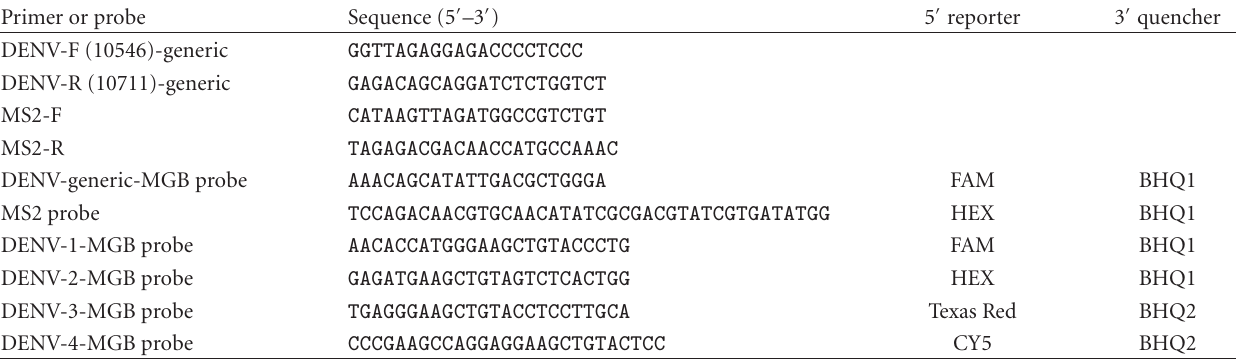
Table 1: Primers and fluorescence-labeled probes of DENV and noncompetitive IC (MS2 RNA).